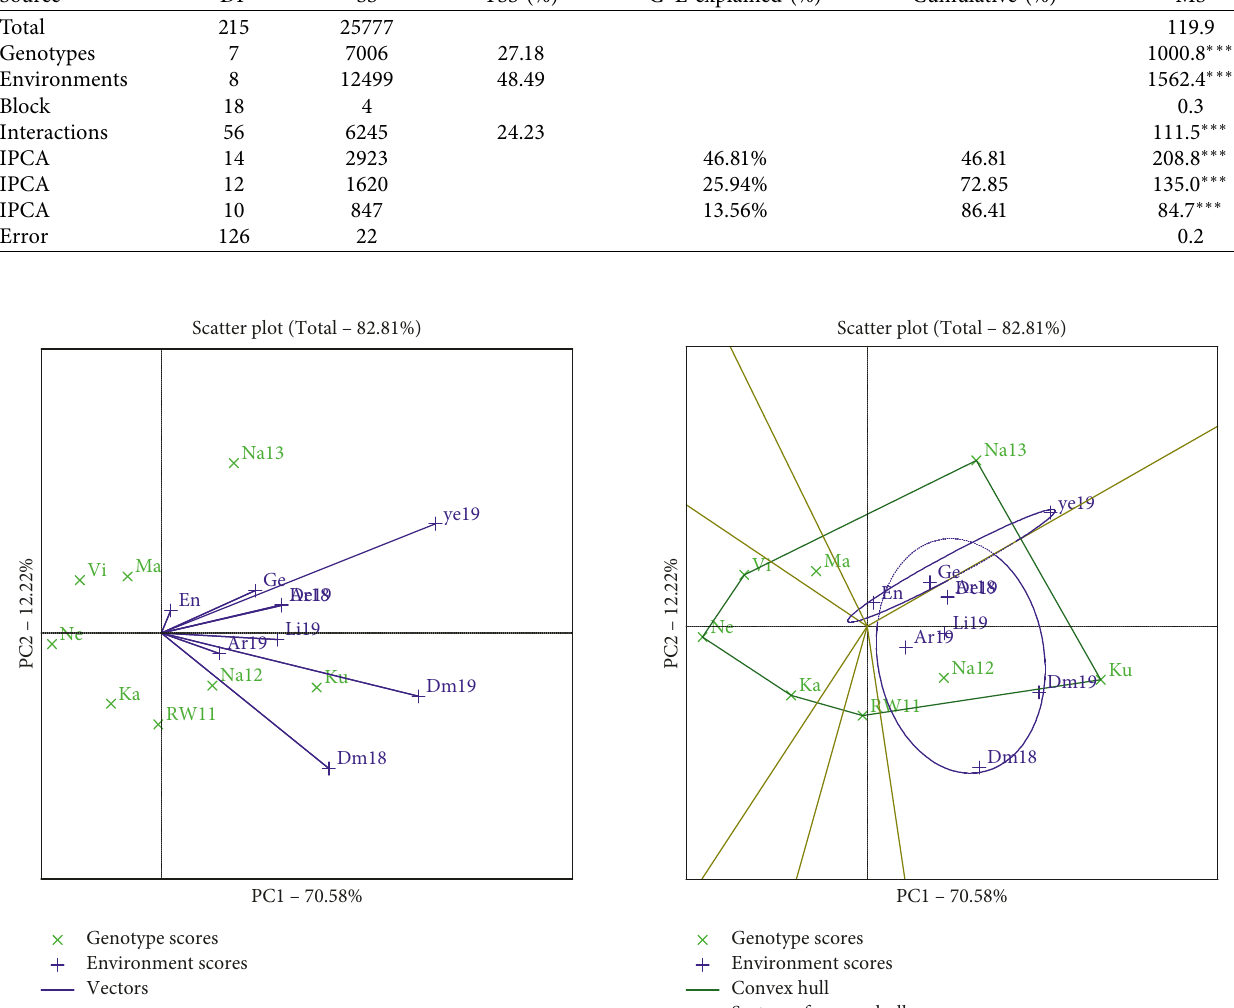
Figure 2: GGE Biplot view of eight varieties over nine environments.